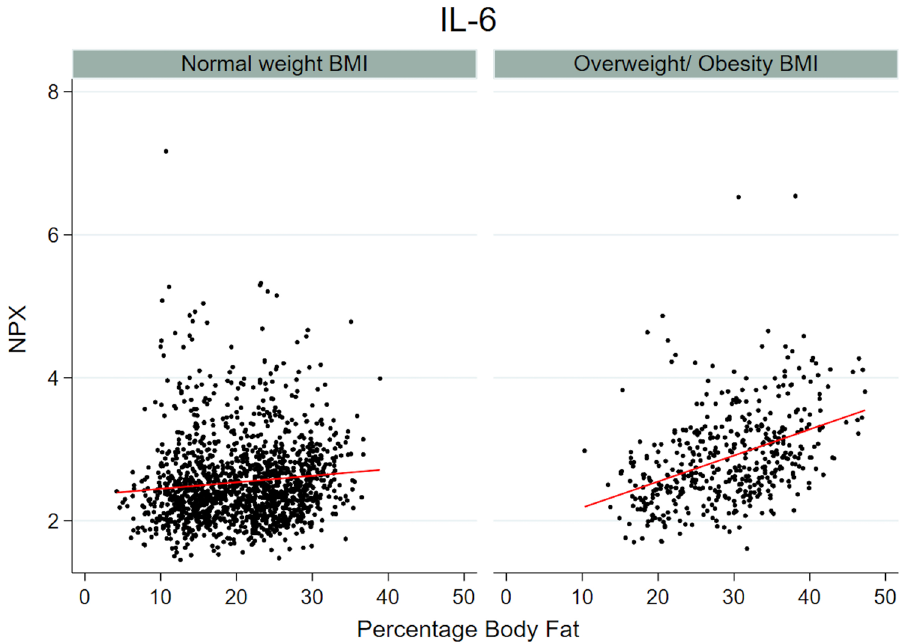
Figure 4. Example of effect modification by BMI category. IL-6 and association with %BF in normal weight and overweight/obese subjects. Scatterplot and regression line of protein level (in NPX) and %BF in normal weight and overweight/obese BMI groups